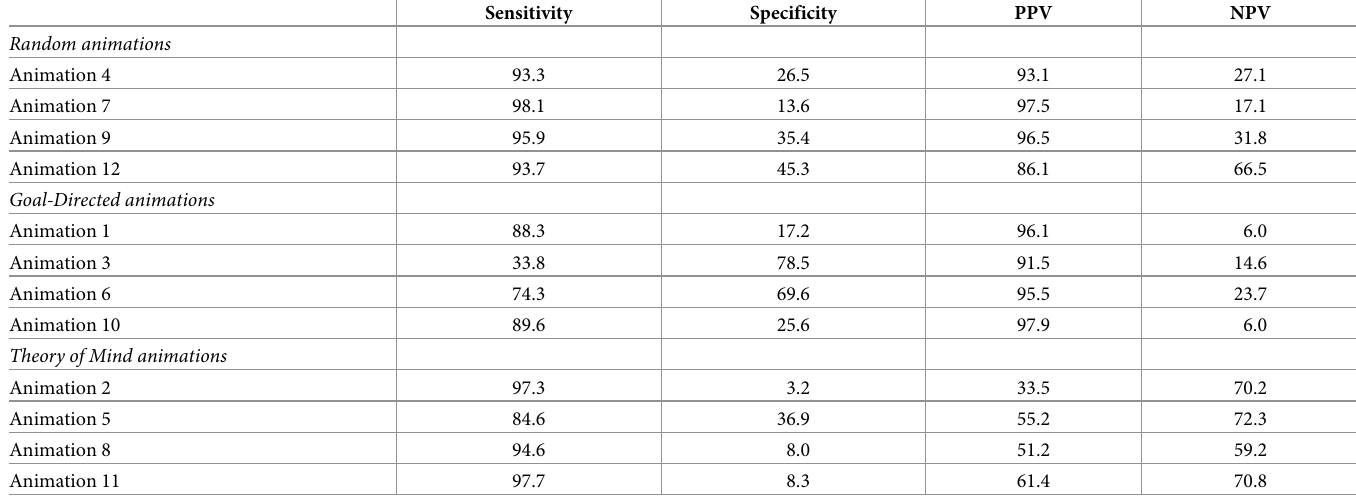
Table 4. Sensitivity, specificity, positive predictive value (PPV) and negative predictive value (NPV) for the correct AT-MCQ categorization with the corresponding grouped AT-verbal intentionality score as reference method a .